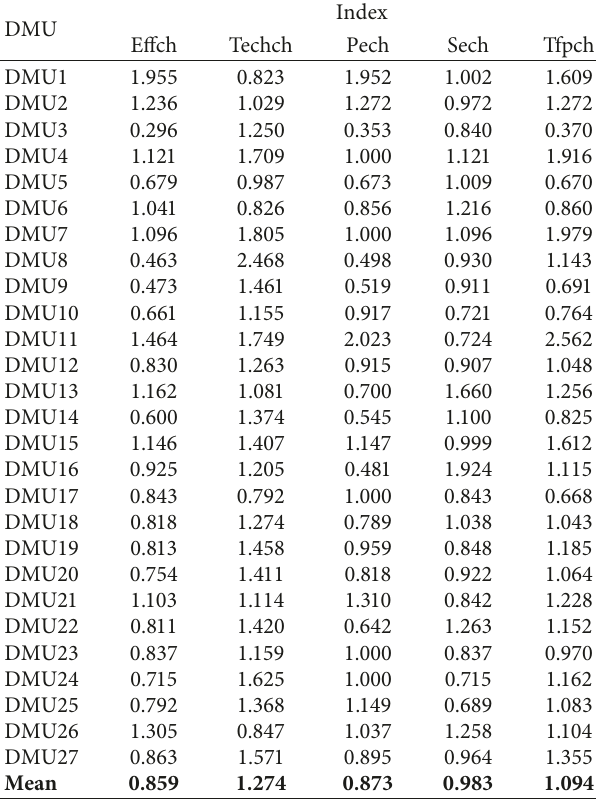
Table 5: Calculation results of innovation performance of 27 manufacturing segments in Wuhan,